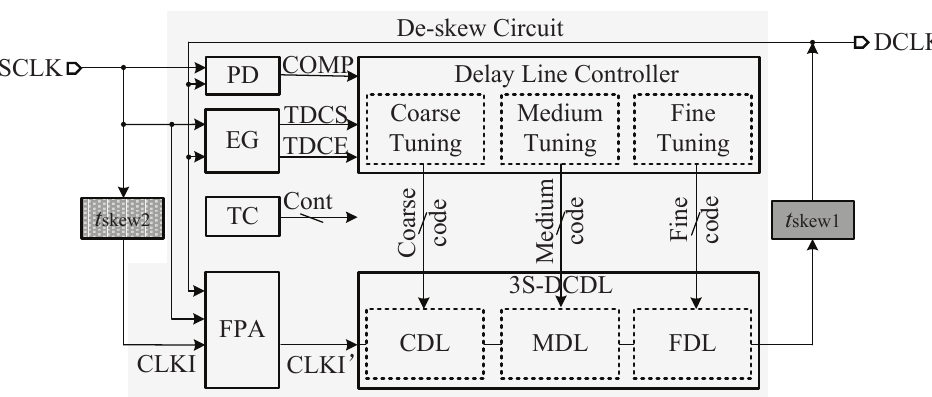
Figure 3. The specific structure of the de-skew circuit.